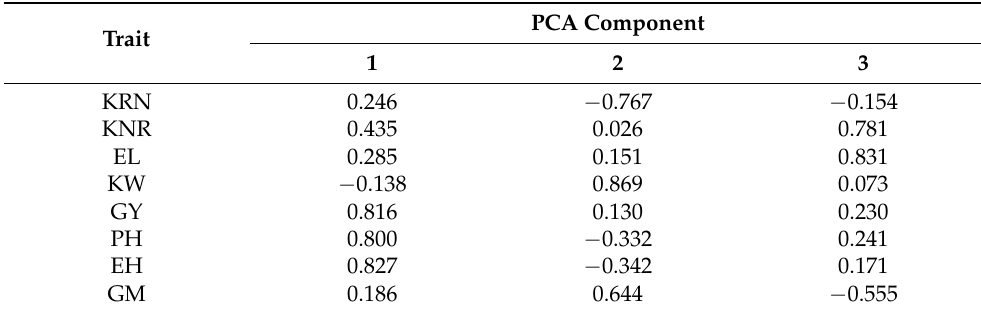
Table 2. Rotated component matrix (a) of the tested traits in top-cross hybrids. Abbreviations: KRN: number of kernel rows; KNR: number of kernels per rows; EL: ear length; KW: 1000 kernel weight; GY: grain yield (t ha − 1 ); PH: plant height; EH: ear height; GM: grain moisture. Extraction method: principal component analysis. Rotation method: Varimax with Kaiser Normalization. Rotation converged in eight